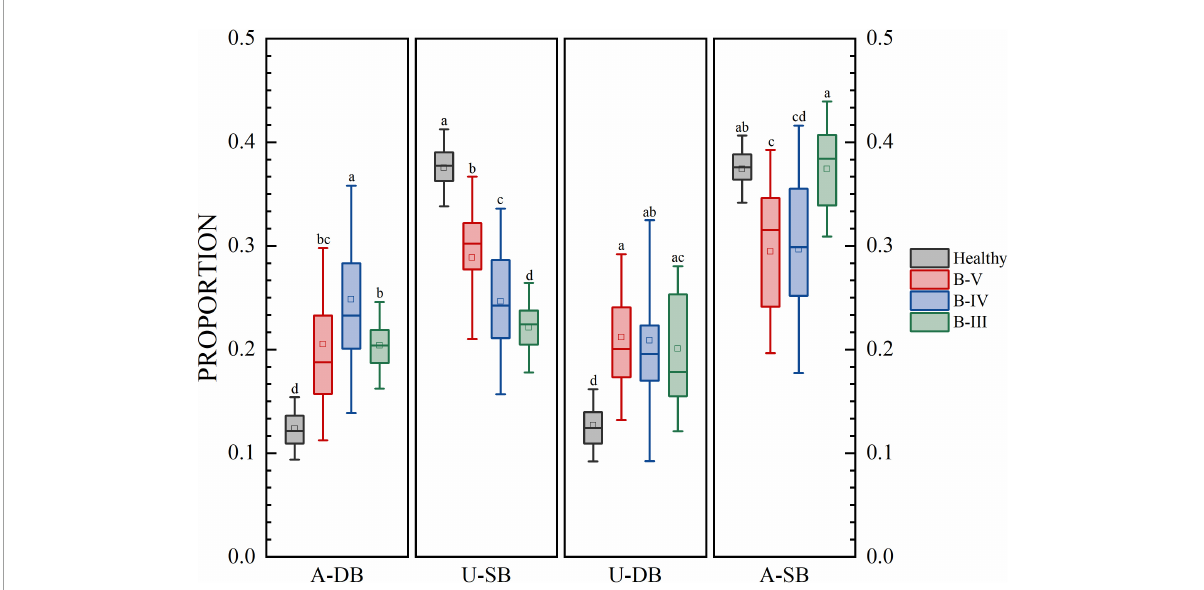
FIGURE3 The proportion of each gait phase of subjects at each stage. Different low case letters above columns indicate statistical differences at P < 0.05.